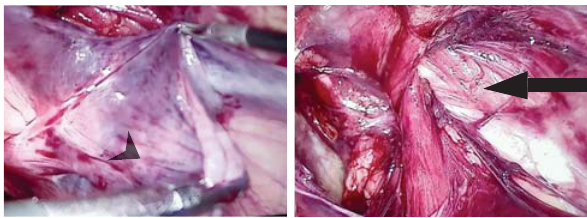
Figure 1. Intraoperative view: Arrowhead: dissected sac. Arrow: